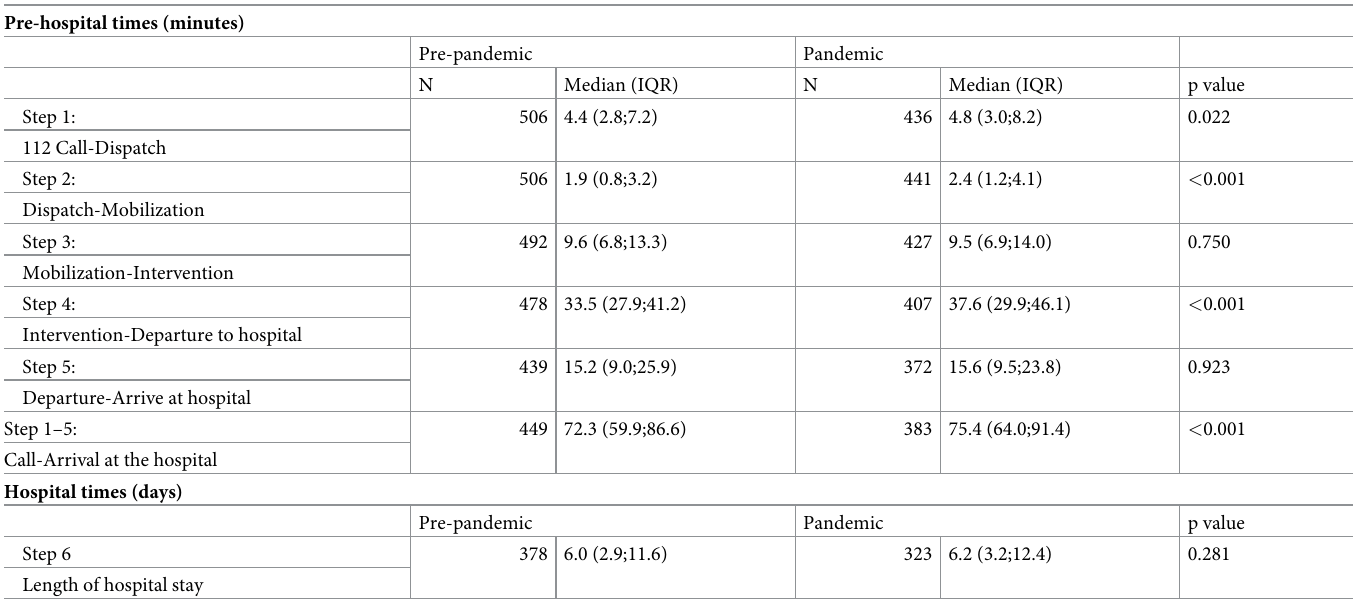
Table 2. Time invested in each of the phases of prehospital and hospital